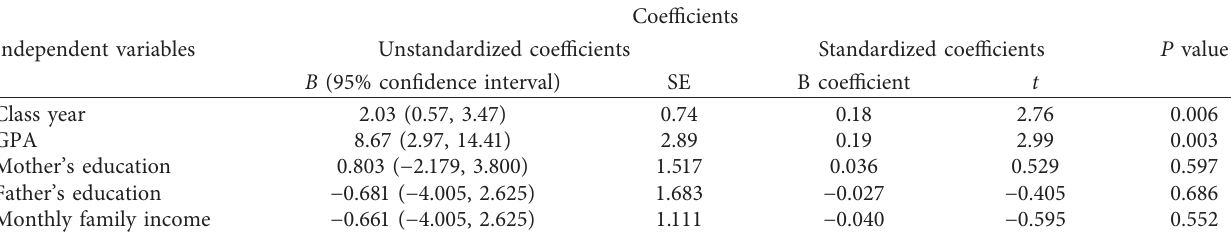
Table 4: Multivariable linear regression analyses: correlation between sociodemographic factors and empathy among study participants. Independent